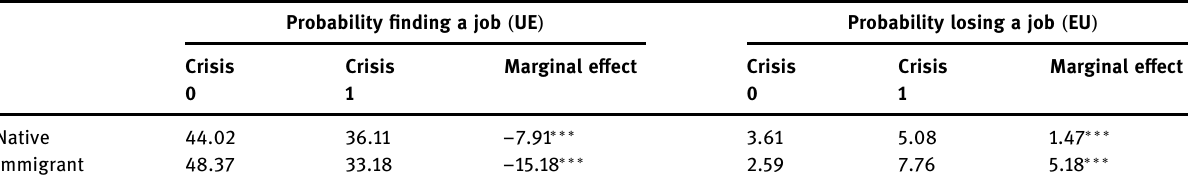
Table 3: Adjusted predictions and marginal e ff ect Probability fi nding a job ( UE ) Probability losing a job ( EU ) Crisis Crisis Marginal e ff